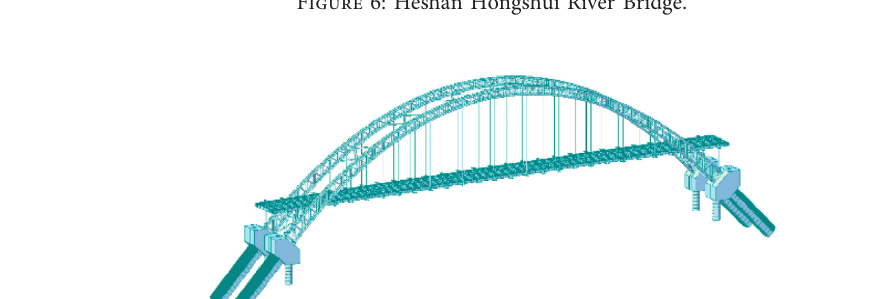
Figure 6: Heshan Hongshui River Bridge.